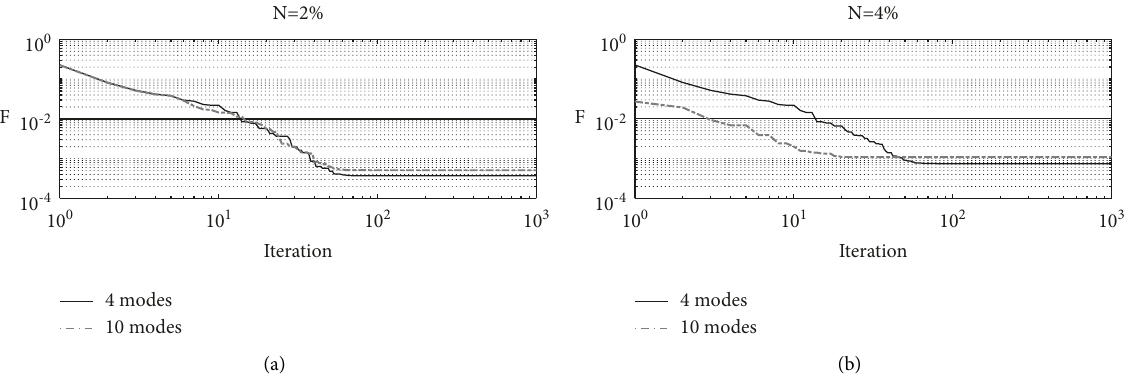
Figure 4: Convergence rates of the EO algorithm in step 2 for the 40-element beam; (a) under 2% noise, (b) under 4% noise in measured natural frequencies.